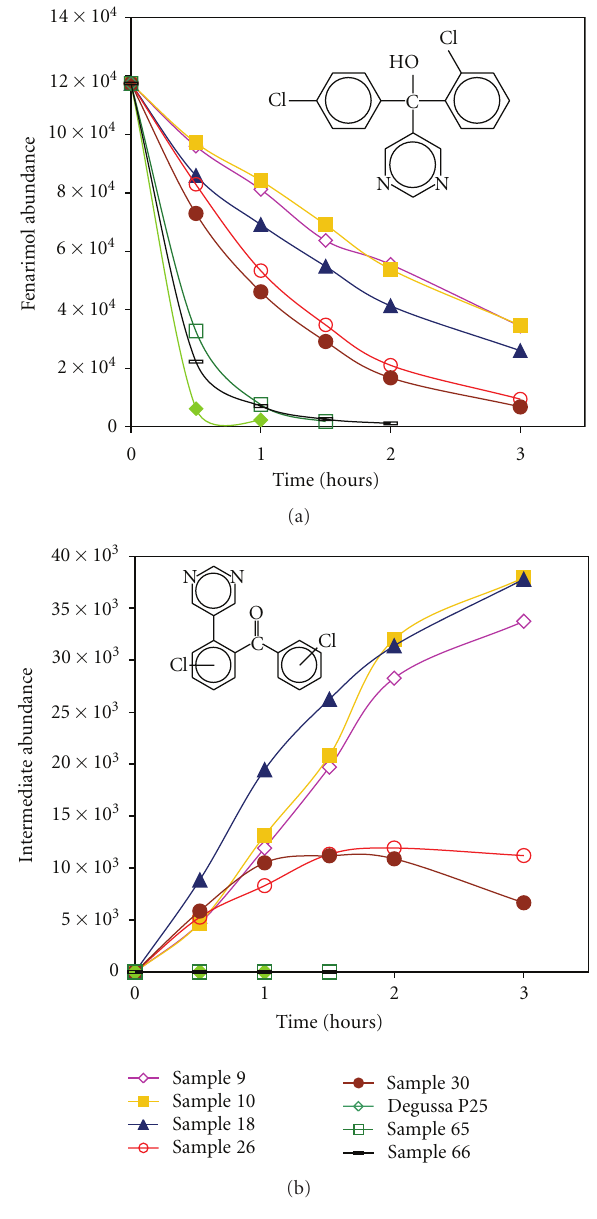
Figure 10: Contents of Fenarimol solution (a) and intermediate photoproduct (b) in dependence on time, under UV illumination, when in contact with several di ff erent TiO 2 thin